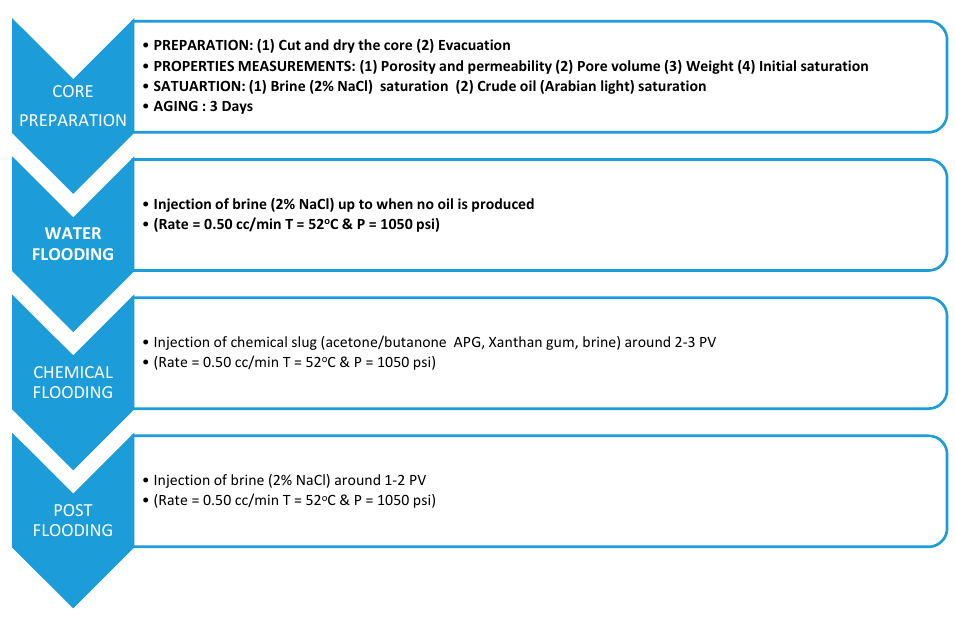
Figure 4. Core flooding procedure. Table 4. Core Properties.